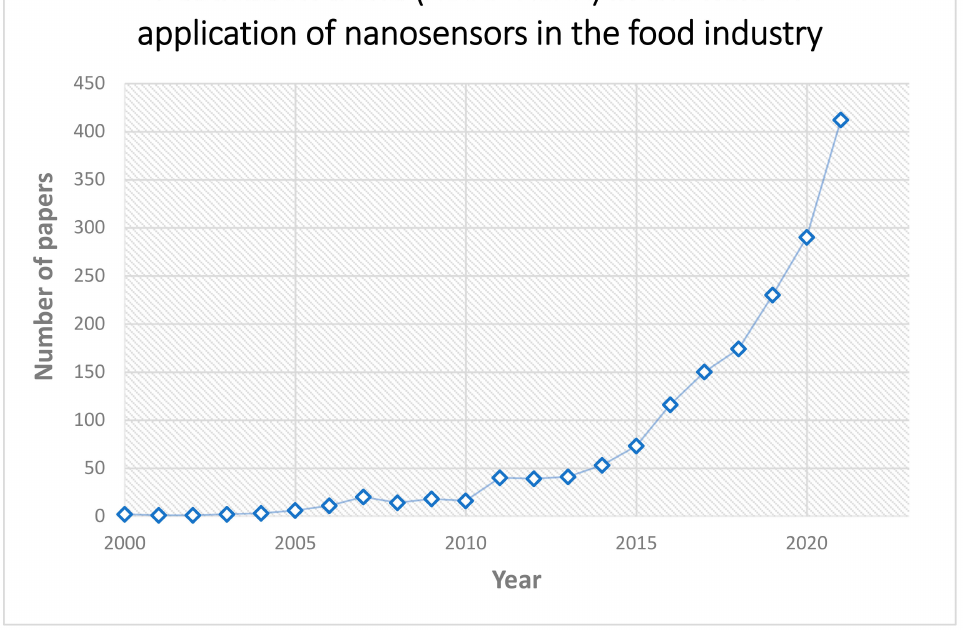
Figure 2. Publication trend (2000–2021) in the field of application of nanosensors in the food in- dustry (source of raw data: https://www.sciencedirect.com; search keywords: nanoparticle, food,